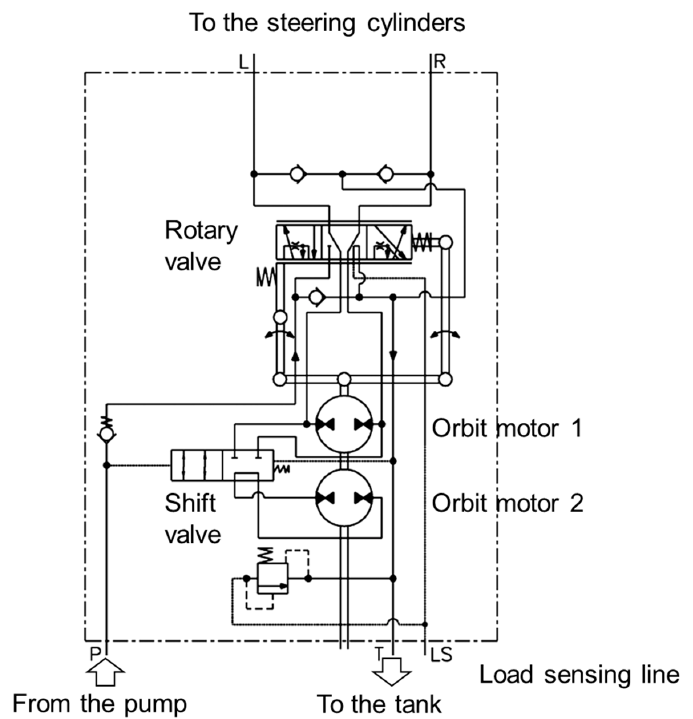
Figure 1. Circuit layout of the steering system for an agricultural tractor.